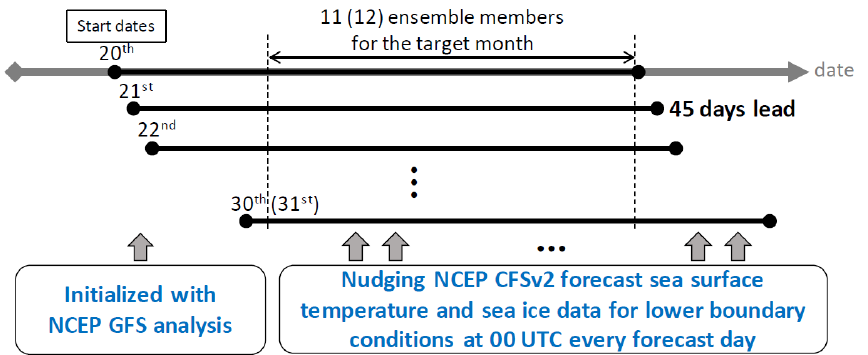
Figure 1. Schematic diagram of the hindcast experiments. A series of 45 day hindcasts are made for December, January, and February from 2011 to 2020. Each hindcast is initialized with NCEP GFS analysis at 00 UTC from 20th to 30th (31st) in November, December and January. Totally 11 (12) ensemble members’ simulations that can cover the next month. During simulations, the NCEP CFSv2 forecast sea surface temperature and sea-ice data are used as model lower boundary condi- tions at 00 UTC every forecast day.